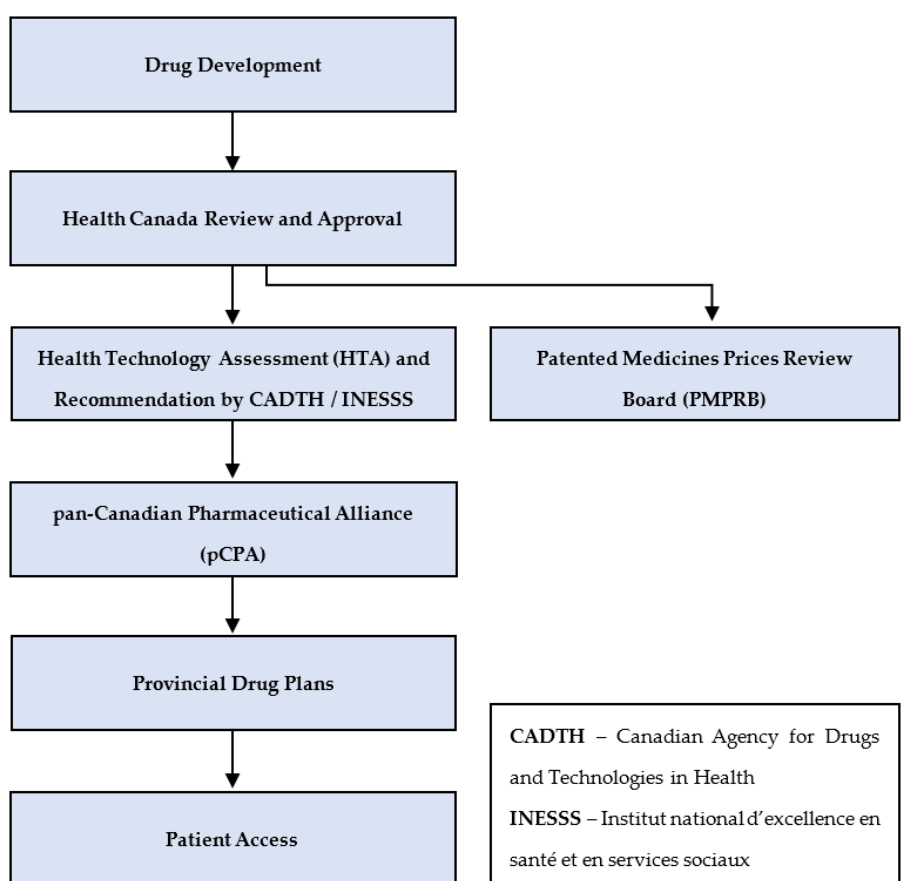
Figure 1. Overview of key steps in the public approval and reimbursement pathway, excluding hospitals. Adapted from [1]. After a drug is developed, the manufacturer submits it to Health Canada for approval for sale [8]. If approved, the manufacturer applies to the Patented Medicines Prices Review Board (PMPRB) for a review of its proposed list price [13]. The manufacturer also generally applies to one or both health technology assessment (HTA) processes in Canada, CADTH for all provinces/territories, except Quebec, which relies on INESSS [1]. If recommended for reimbursement, the manufacturer applies to the pCPA to negotiate a price with the participating